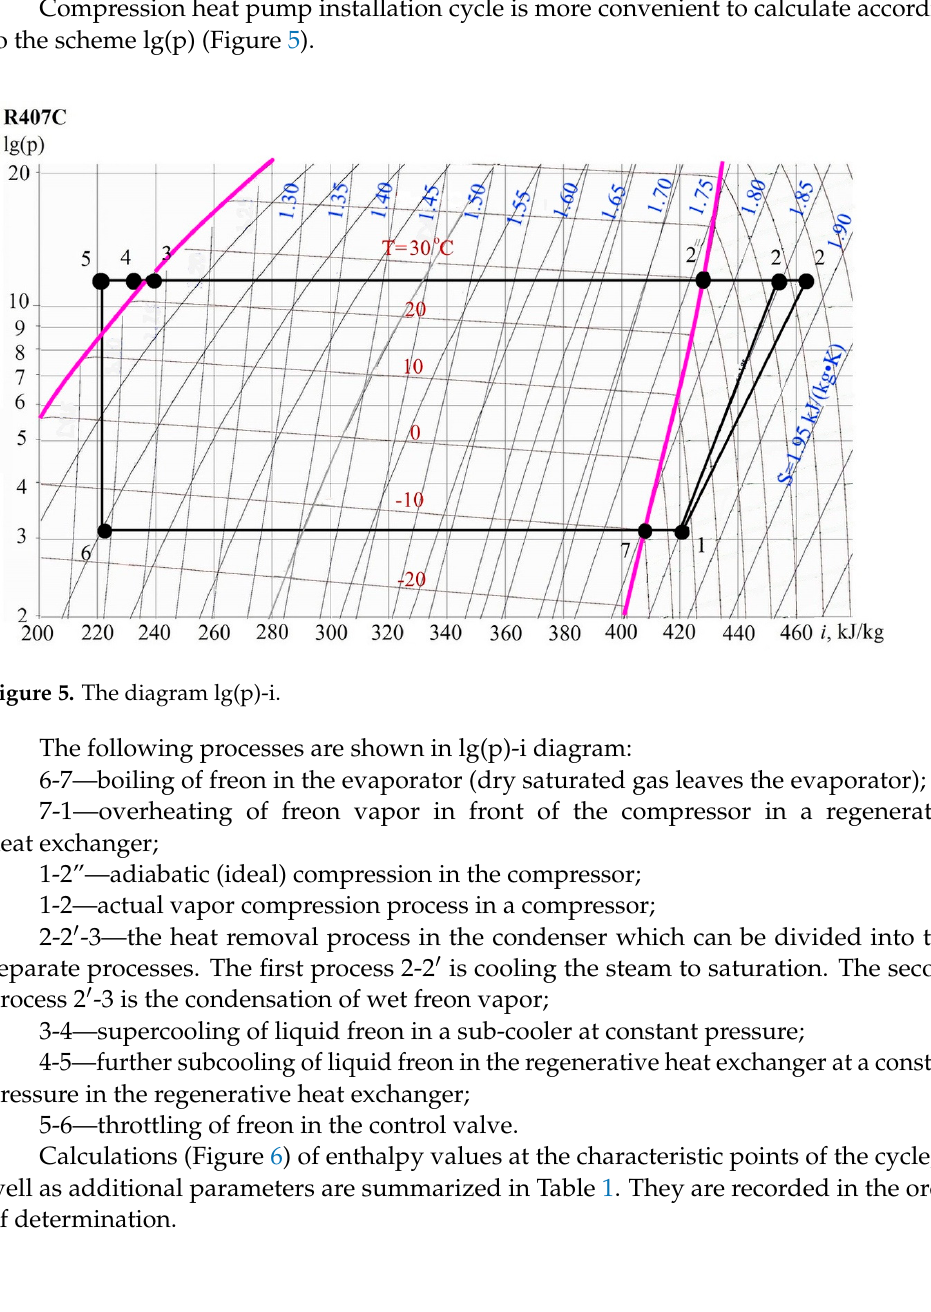
Figure 6. The diagram T-s.